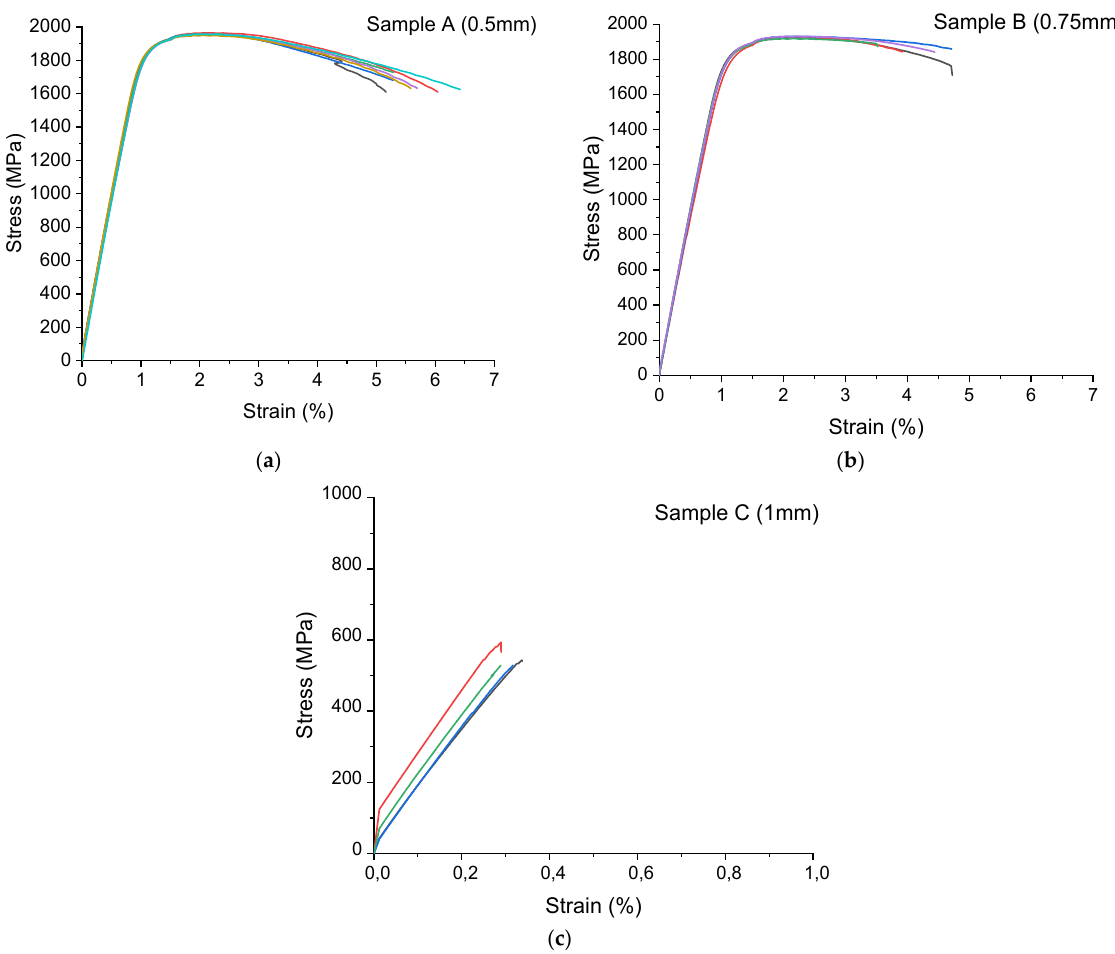
Figure 9. Tensile stress – strain curve for ( a ) sample A (layer thickness — 0.5 mm); ( b ) sample B (layer thickness — 0.75 mm); ( c ) sample C (layer thickness — 1 mm). Overlapping curves on each graph represent the repetitions for the same sample state. Fractures of samples after tensile testing were observed (Figure 10). The cracks for specimens with layer thicknesses of 0.5 mm and 0.75 mm occurred at an angle of 45° to the tensile direction, while the crack plane for the specimen with a layer thickness of 1 mm was perpendicular to the loading direction. At each fracture, unmelted powder particles and voids (porosity) were revealed. For samples A (layer thickness 0.5 mm) and B (layer thickness 0.75 mm), the unmelted particles and porosity were significantly lower than those for sample C (layer thickness 1 mm). Based on the tensile test results, specimens A and B were found to break after substantial plastic deformation. For specimen C, the fracture was found to be close to brittle (insignificant elongation at break), which shows that the layer thickness of the overlay of 1 mm is a threshold value, and parts made with this parameter or higher for 600 W laser power are not valuable for use in the industry.